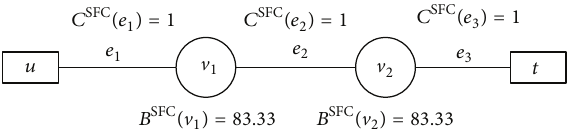
Figure 1: An example of graph representing an SFC request for a flow characterized by the bandwidth of 1Mbps and packet length of 1500